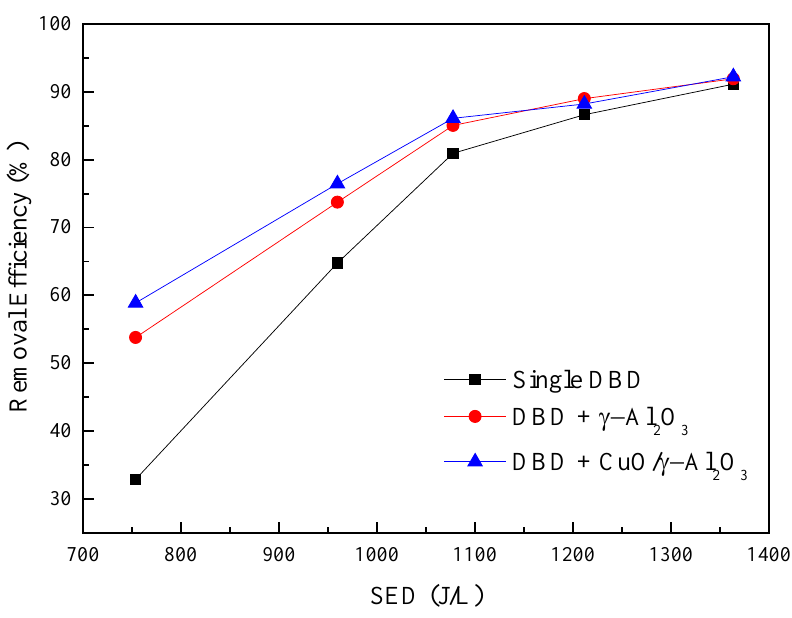
Figure 5. Removal efficiency of chlorobenzene with catalyst loadings and absence of catalyst as a function of SED (flow rate = 3 L/min).